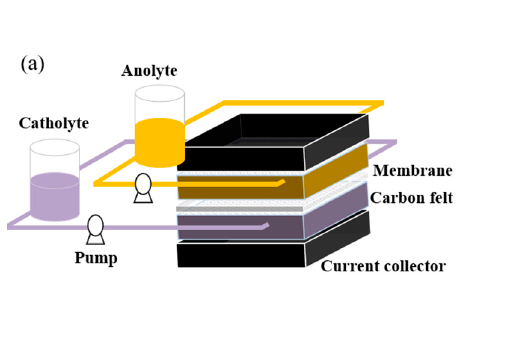
Figure 7. ( a )The second and ( b ) fifth charging–discharging curves of ferrovanadium flow battery in two different ratios of DESs. 𝐶𝐸 (cid:3404) 𝑄 (cid:3031)(cid:3036)(cid:3046) 𝑄 (cid:3030)(cid:3035) ⁄